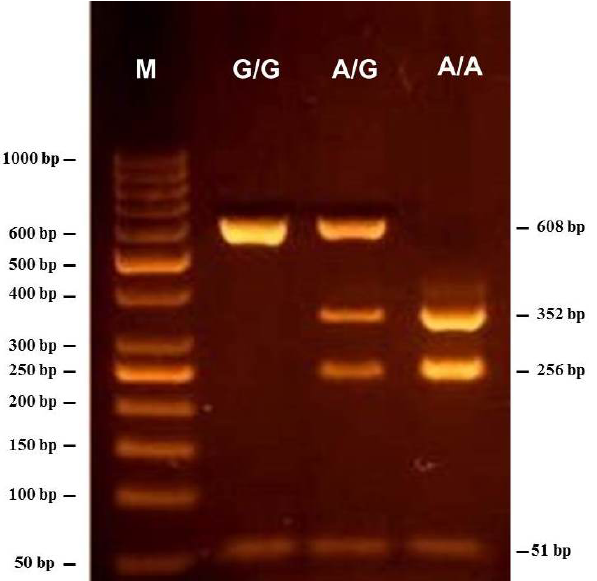
Figure 1. Gel electrophoresis showing the PCR-RFLP products of the SNP identified in the β -casein (CSN2) gene of Camelus dromedarius . The genotypes are indicated at the top of each lane. M is 50bp DNA ladder